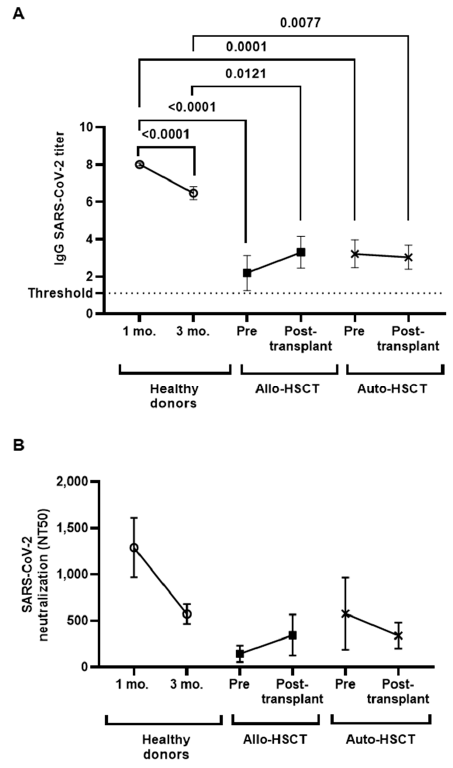
Figure 1. Serological response against SARS-CoV-2 vaccine in plasma from individuals with OHD subjected to Allo- and Auto-HSCT. ( A ) Plasma IgGs titers in individuals with Allo- or Auto-HSCT were compared between them and with healthy donors. ( B ) IgG neutralizing activity against SARS- CoV-2. Each dot corresponds to the mean ± standard error of the mean (SEM). Different cohorts are marked with the following symbols: Healthy donors (white circles), Allo-HSCT (black squares), and Auto-HSCT (cross). A one-way ANOVA test was applied to calculate the statistical significance between groups, and t -test was applied to calculate the statistical significance within